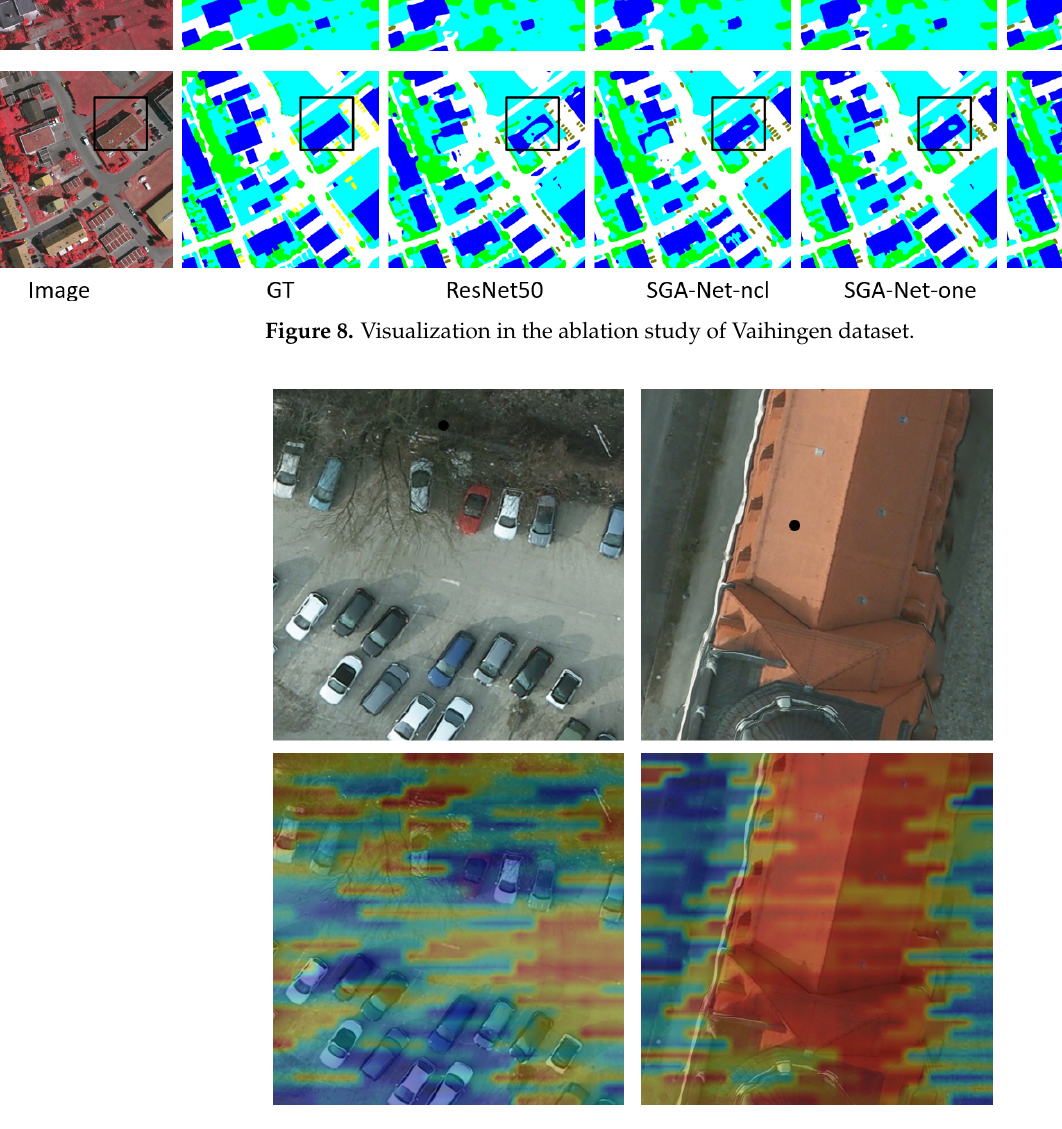
Figure 9. Visualization of the attention mechanism. The black dot is the target pixel or object. The red pixel color indicates that the target pixel is very similar to this pixel, and the blue color indicates that the target pixel is strongly different to this